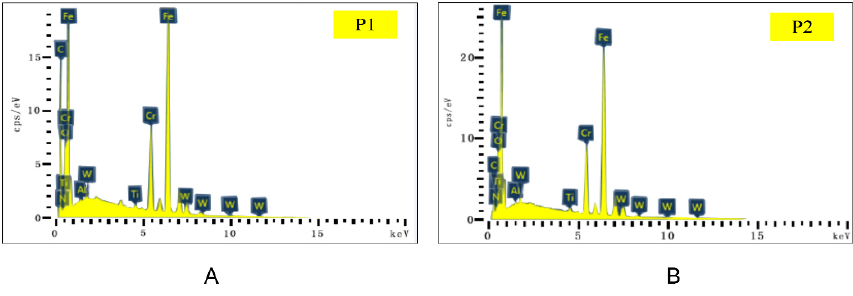
Figure 18. EDS analysis results of corresponding points P1 ( A ) and P2 ( B ) in Figure 17.